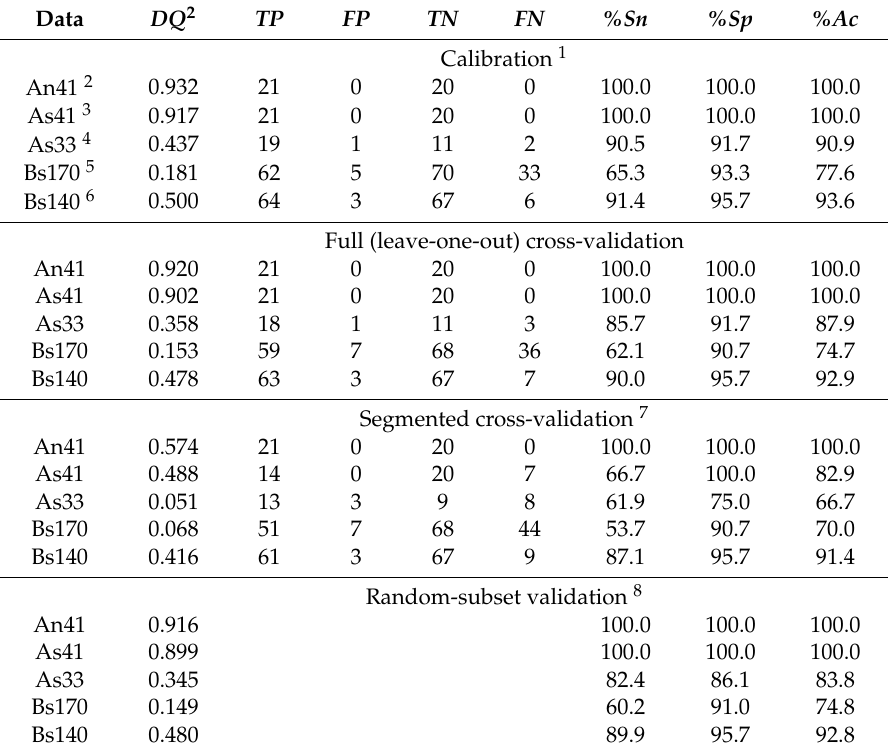
1 Both training and validation of the model were performed using the full dataset. 2 Near-infrared (NIR) spectra of Series A. 3 Simulated sensor data in Series A. 4 Sensor measurements in Series A. 5 Sensor measurements of full data in Series B. 6 Sensor measurements of Series B without sample T 151 or positions N 144 _Cn and T 144 _Cn . 7 Segments were formed by samples (Series A) or measurement positions (Series B). 8 Subset (15%) of the full data at 1000 iterations.